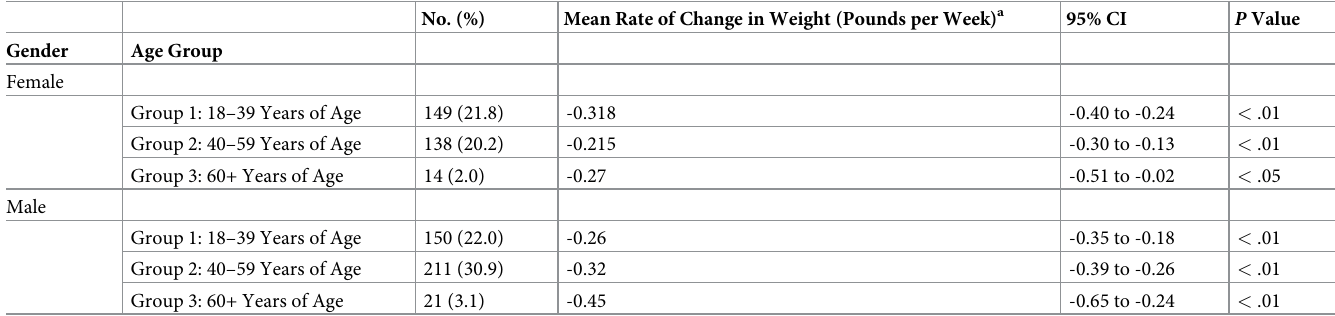
Table 3. Rates of change across demographic groups.